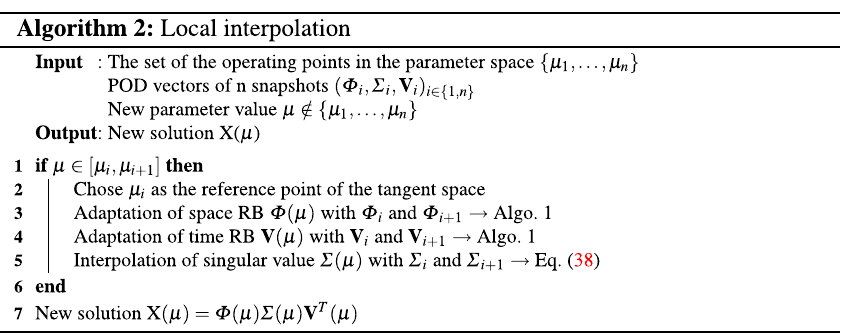
Welding finite element